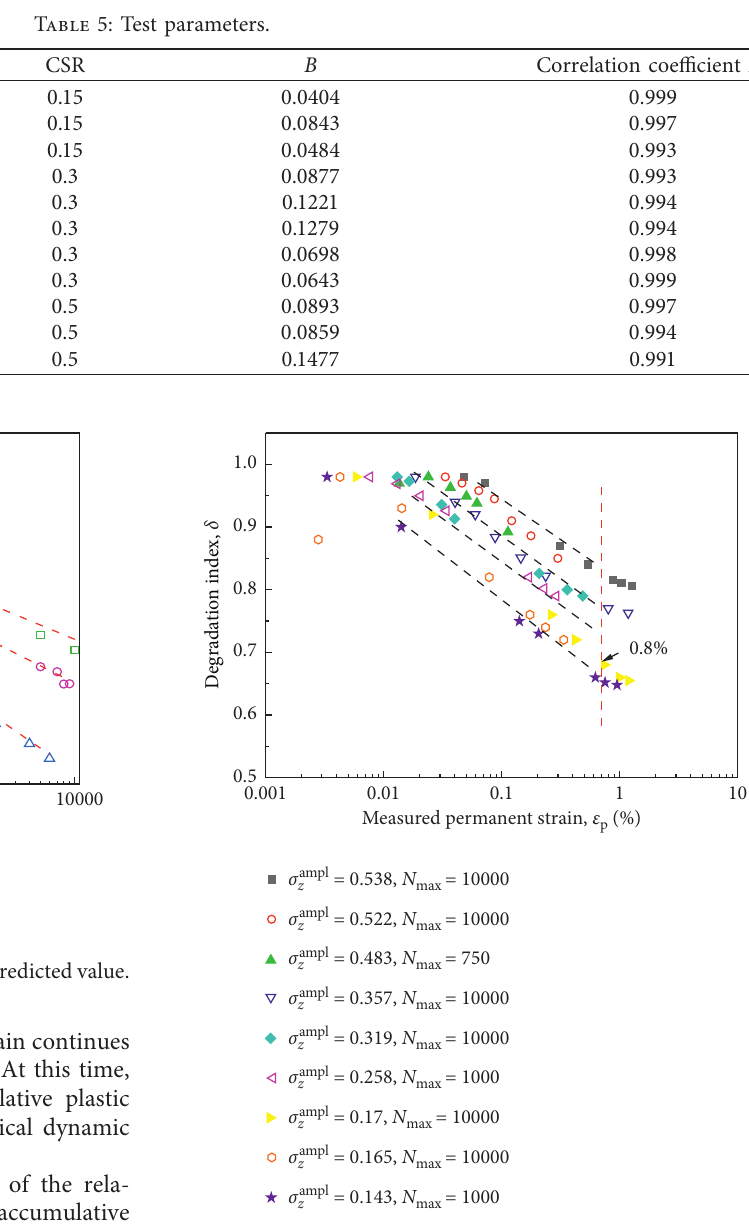
Figure 11: Relationship of the cyclic stress ratio (CSR) and δ versus ε p